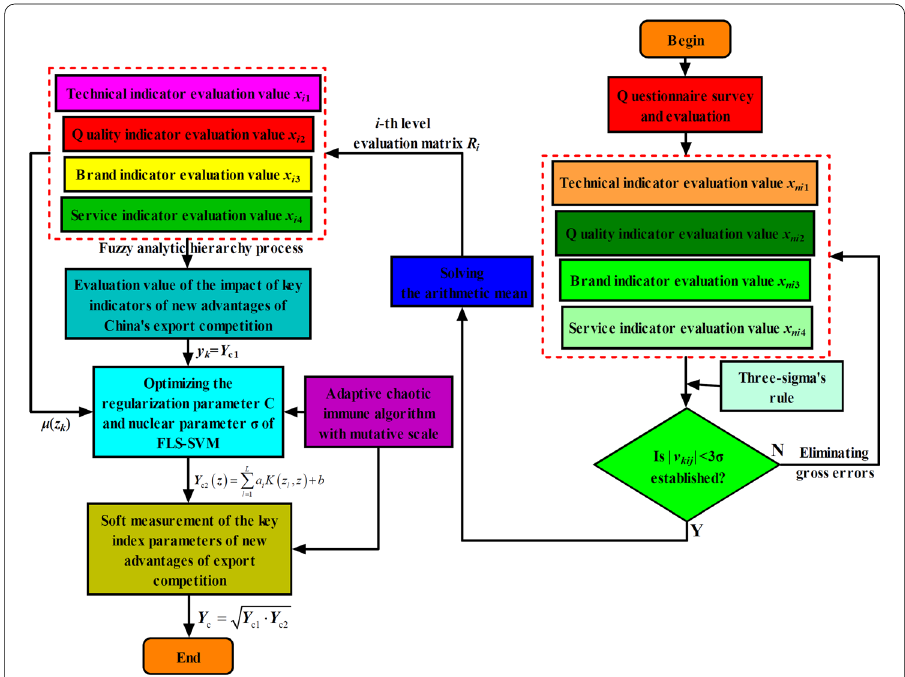
Fig. 1 Flow chart of the key indicator parameters measurement of the new competitive advantages of China’s